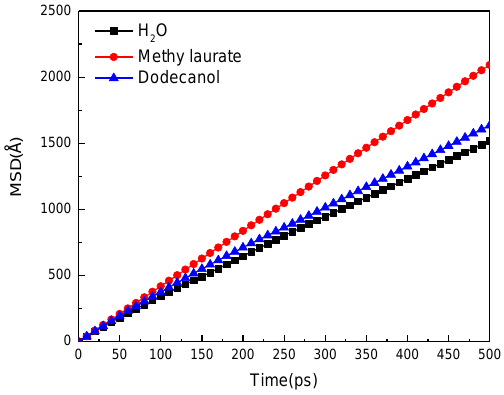
Figure 13. Mean square displacement (MSD) curves of water molecules.